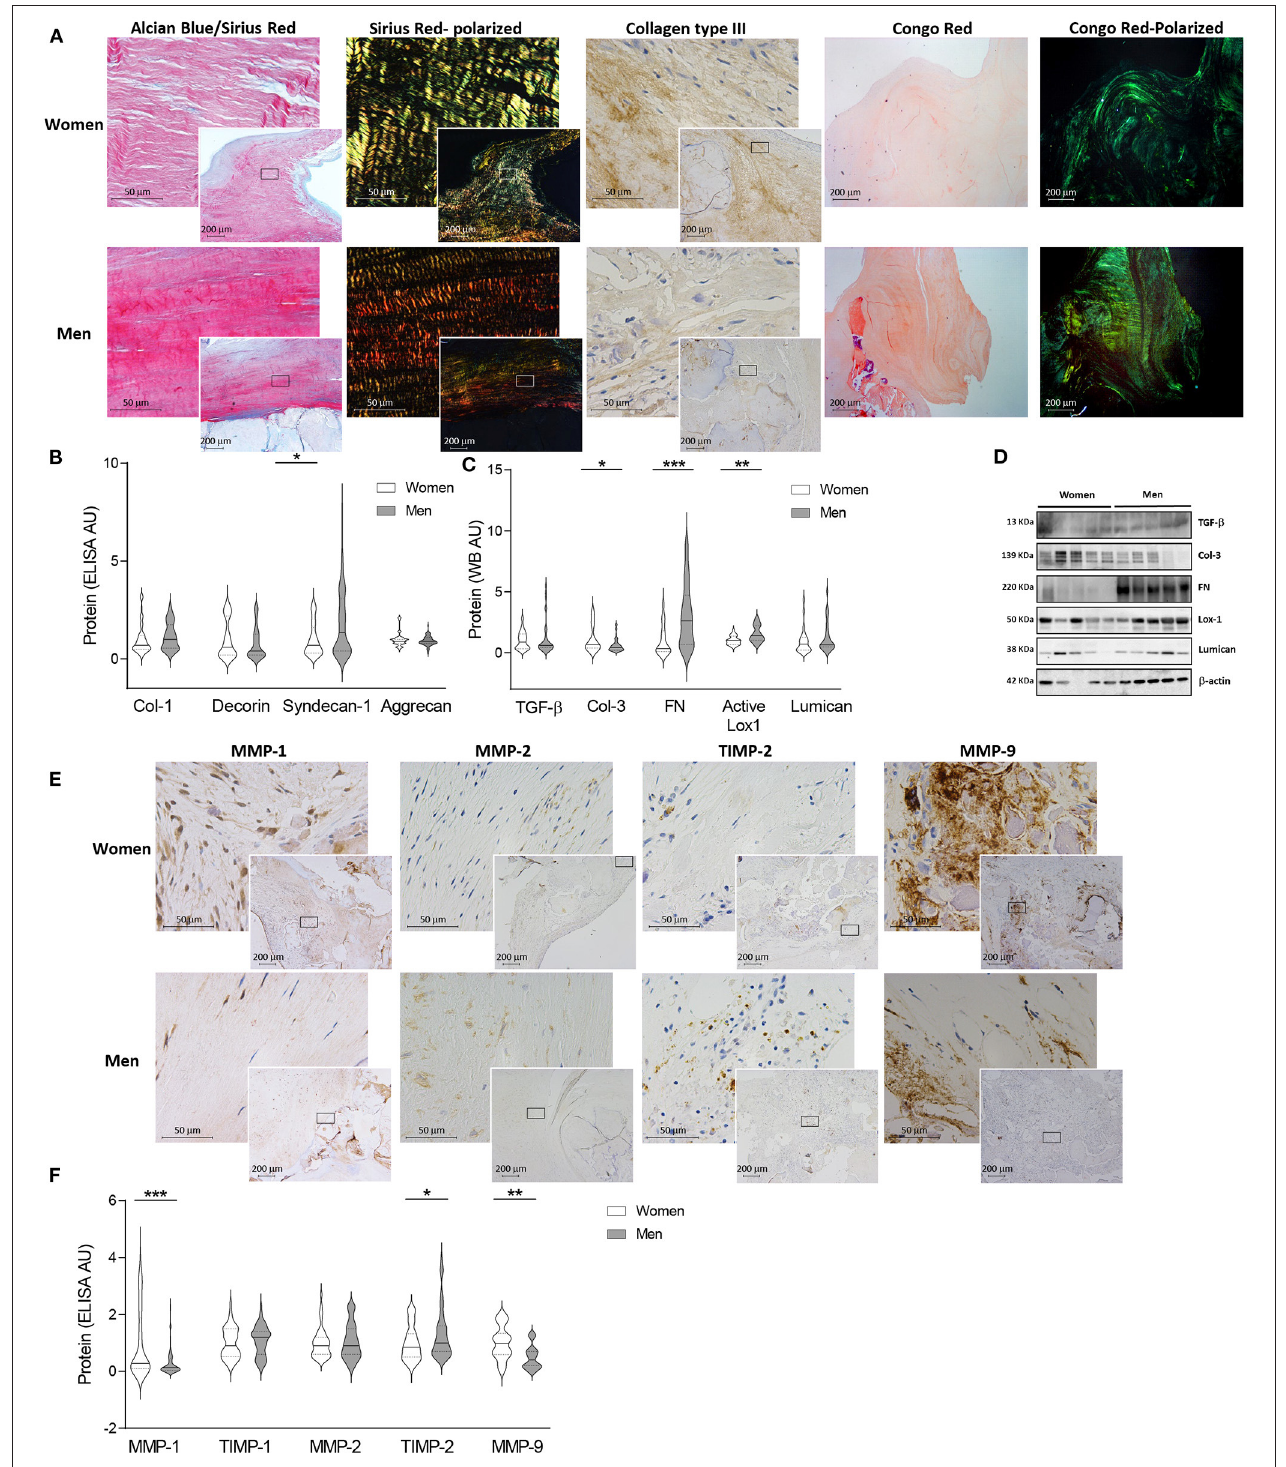
FIGURE 2 | Fibrosis and ECM remodeling markers in women and men AV tissue. Representative microphotographs of AV sections from AS patients stained with alcian blue and Sirius red (AB/SR) double staining, sirius red (SR) with polarized light, collagen type III immunohistochemistry and Congo red with bright field and polarized (A) . Protein levels of several fibrosis and ECM remodeling markers from human AV tissue measured by ELISA (B) and western blot (C) . Representative western blot images for fibrosis markers (D) . Representative immunostainings for MMP-1, MMP-2, TIMP-2 and MMP-9 in women and men valve tissue (E) .